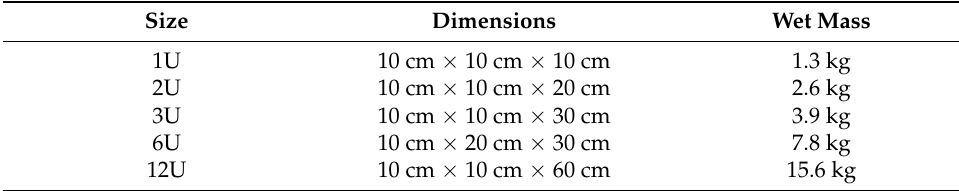
Figure 1. Different CubeSat standards. Table 1. Size and mass of CubeSats.